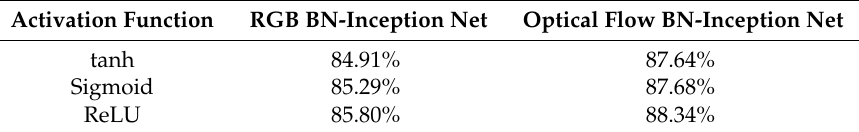
Table 4. Classification accuracies by selecting different activation functions for the attention layer on the UCF-101 dataset (split1).